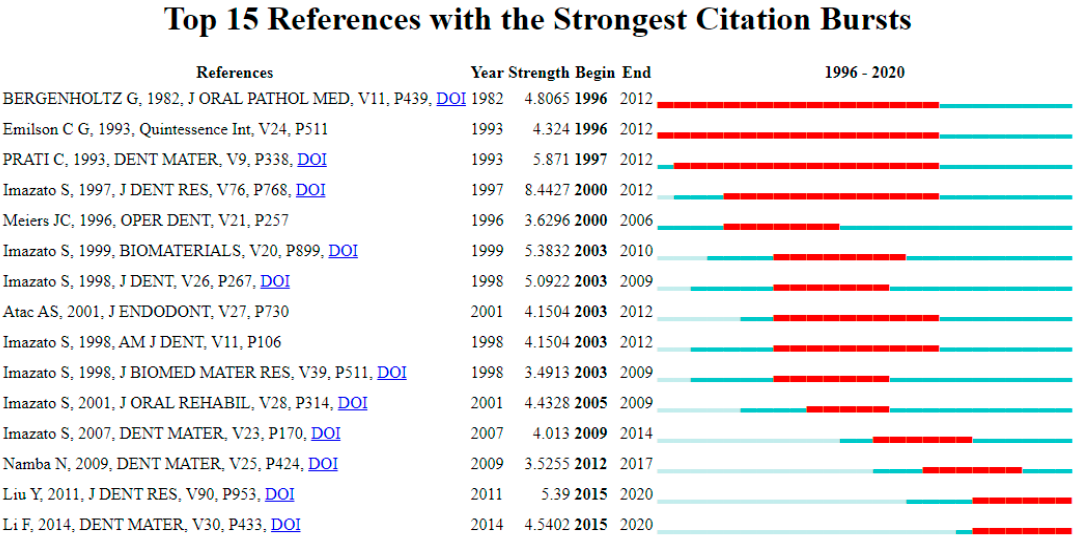
Figure 7. Country collaboration map on dental adhesive literature.